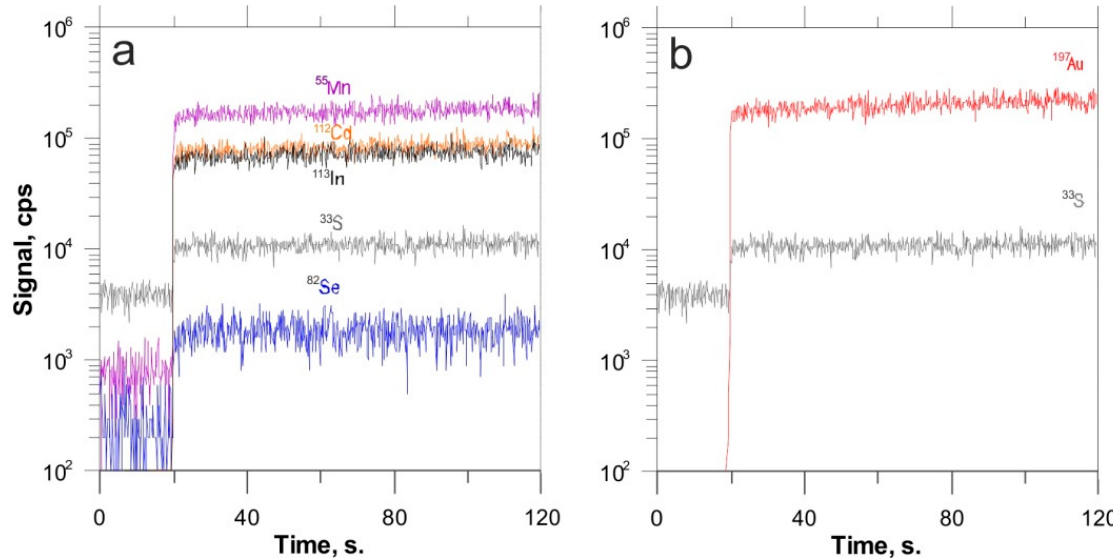
Figure 34. LA-ICPMS profile through sphalerite containing Fe, Mn, In, Cd, Se and Au. ( a )–signals for Mn, Cd, In, S, Se; ( b )-signals for Au, S. See Table 26 for details. Table 26. Chemical composition of ZnS sample 1450 (EPMA) synthesised at 850 °C using the gas transport method with I 2 as a transport agent.